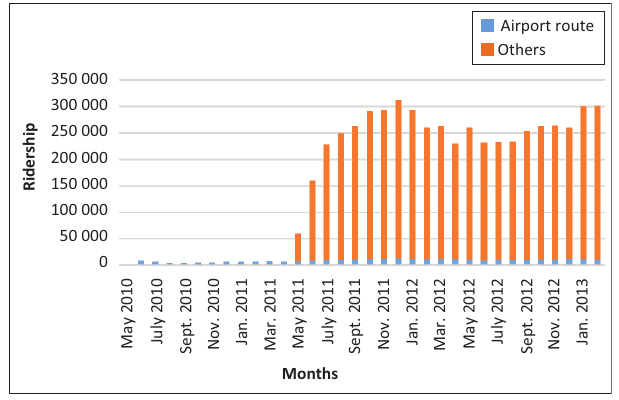
FIGURE 1: Total number of passenger journeys on MyCiTi bus services, May 2010 – February